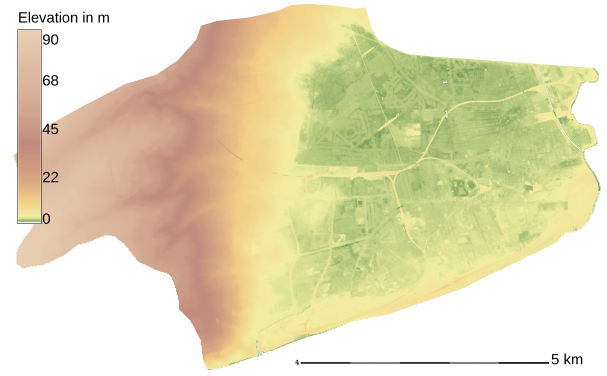
Figure 9. Digital elevation model of Hull.